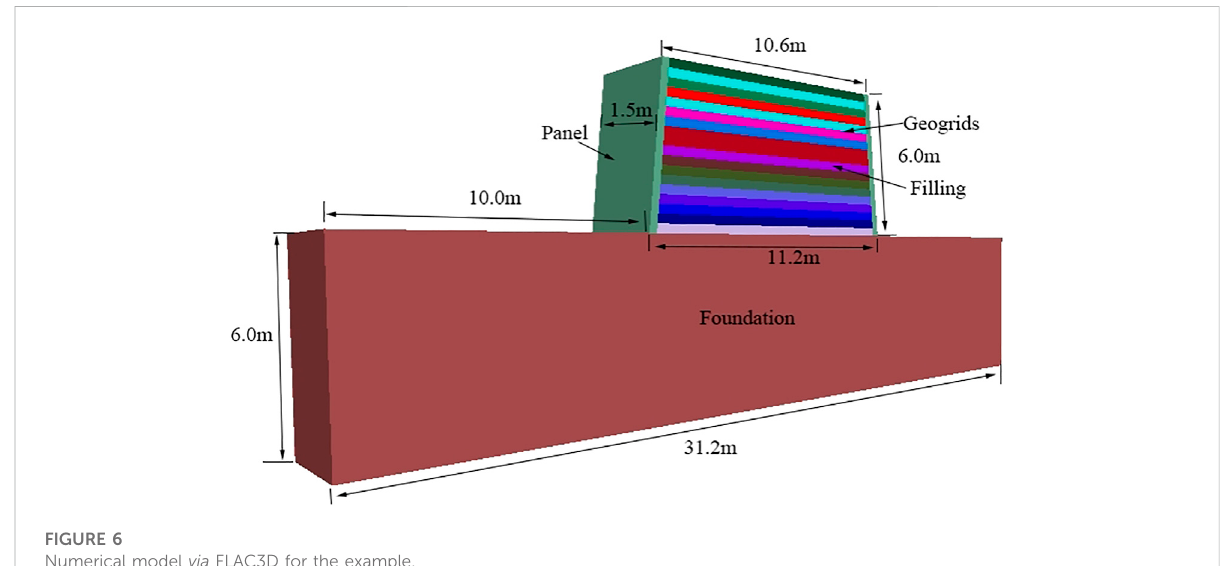
FIGURE 6 Numerical model via FLAC3D for the example.